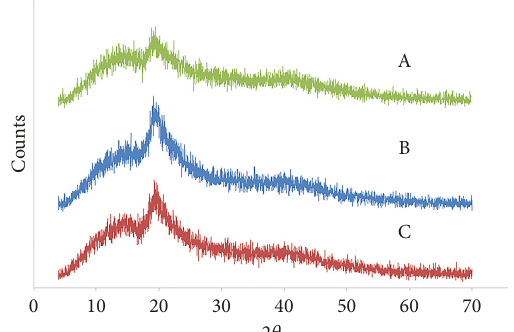
Figure 1: The X-ray diffraction pattern related to crystalline structures within the polymerized acrylic resin containing (a) ZnO/ 4A, (b) TiO 2 /4A, and (c) ZnO/TiO 2